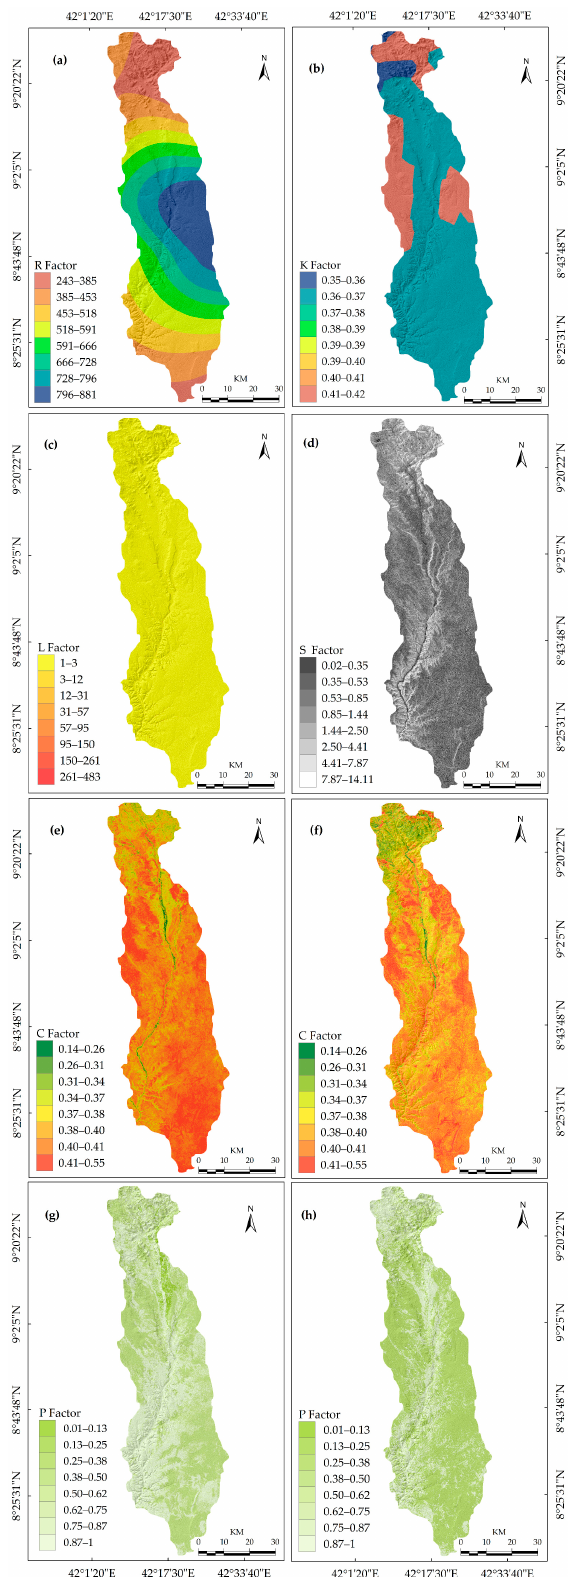
Figure 3. Rainfall-erosivity (R) factor ( a ); Soil erodibility (K) factor ( b ); Slope length (L) factor ( c ), Slope steepness (S) factor ( d ); Cover management (C) factor in 2000 ( e ) and 2018 ( f ); Support practice (P) factor in 2000 ( g ) and 2018 ( h ) in the Erer Sub-Basin, North East Shebelle Basin, Ethiopia.